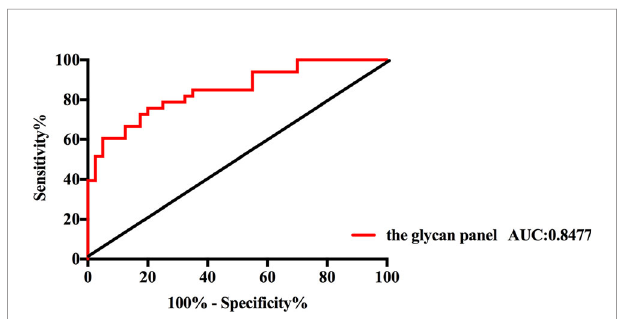
FIGURE 5 | Receiver operating characteristic (ROC) curve analysis for the glycan panel. The ROC was employed to evaluate the discrimination ef fi ciency of the glycan panel. Its AUC value was